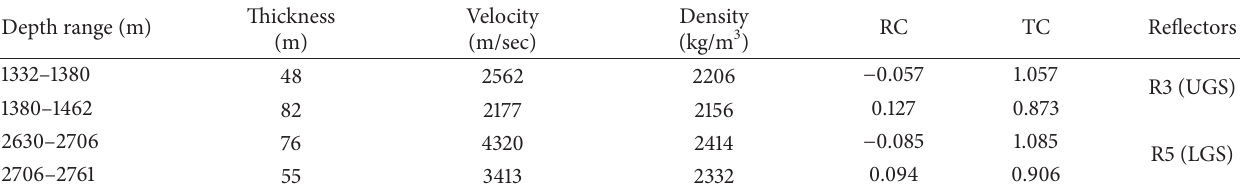
Table 4: Show subsurface seismic interfaces of gas sand horizons in the Rashidpur